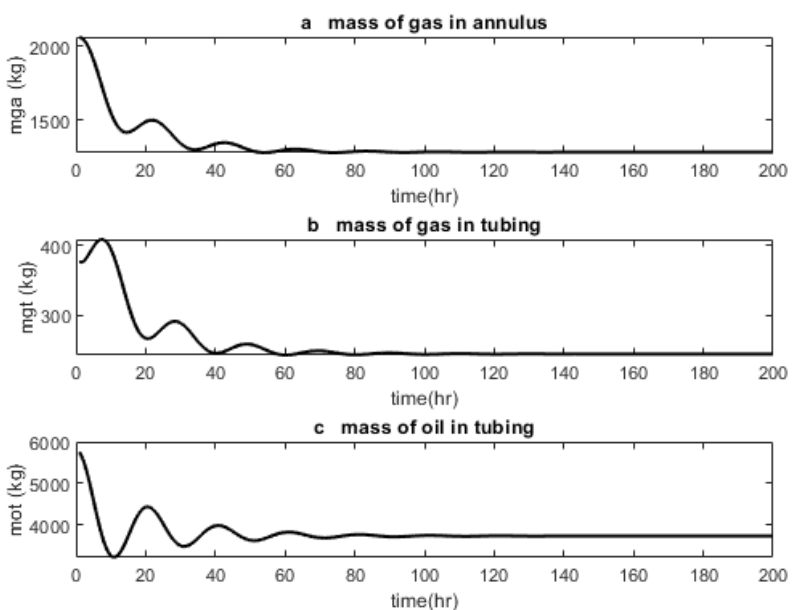
Figure 17. Stablised states of the gas-lift system with PI controller. The oscillation is damped out slowly compared to the use of NMPC.